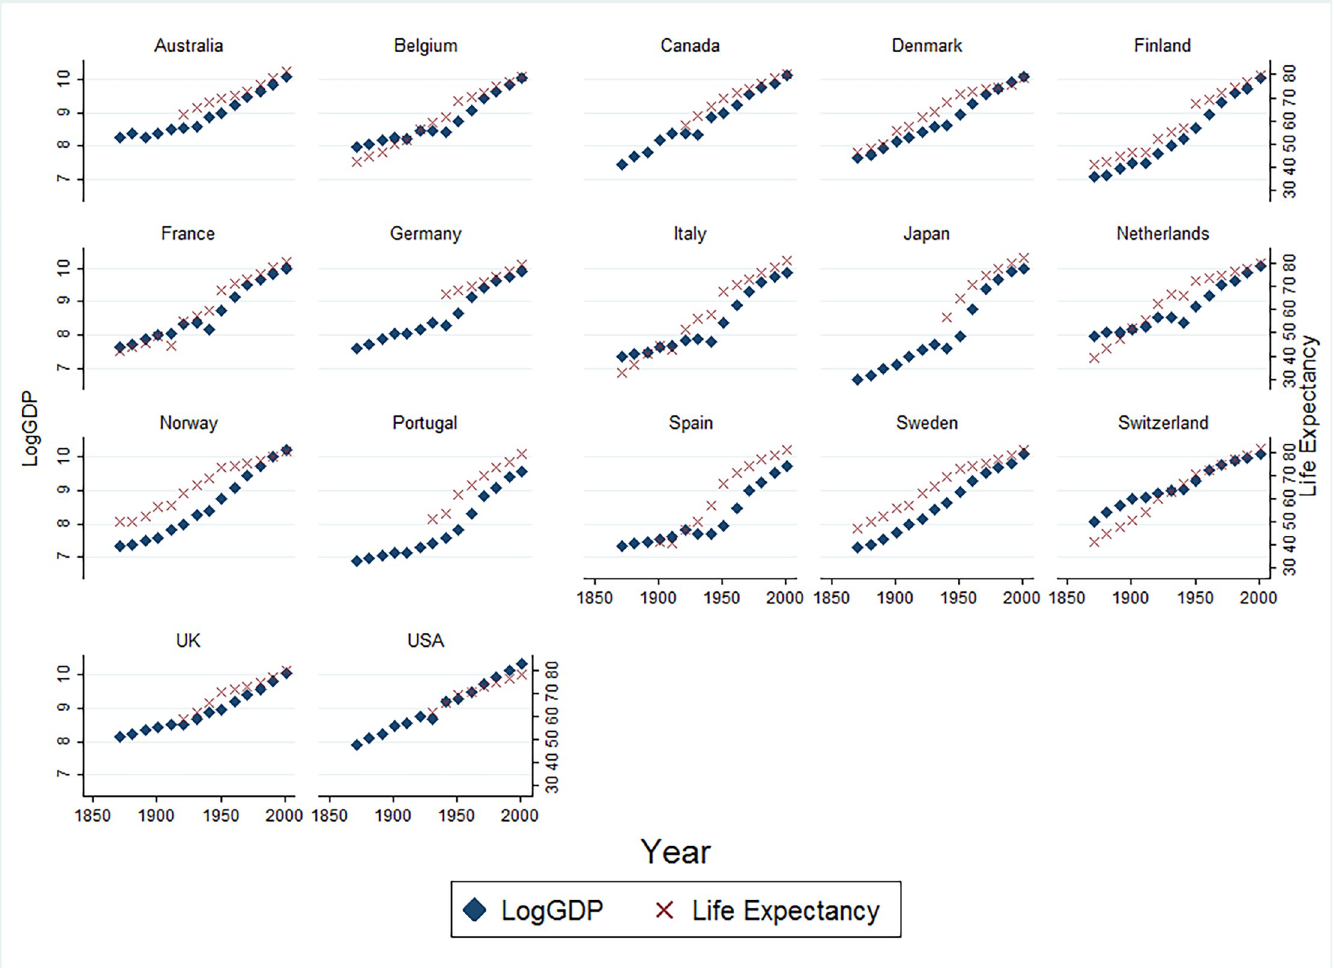
Fig 4. Movement of life expectancy and per capita income: By sample country. The Data pertains to 17 advanced economies in the sample. LogGDP: Natural logarithm of per capita GDP (at PPP prices).